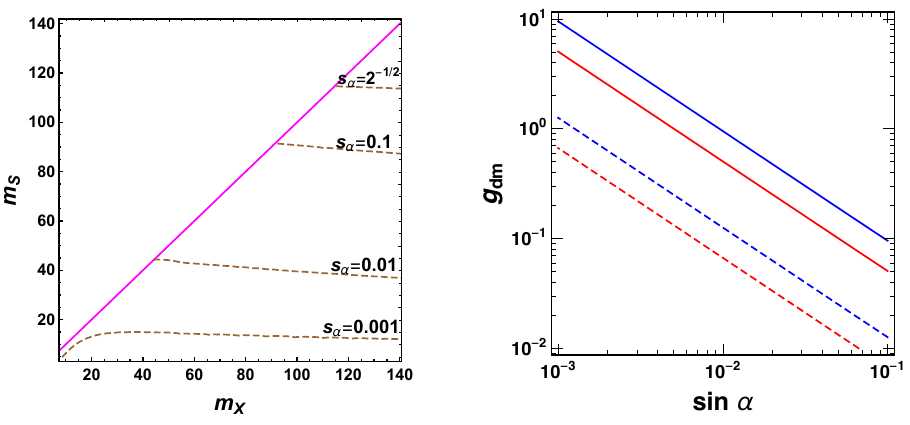
Figure 2 . Left panel: the direct search limit on the ( m X ; m S ) parameter space with the requirement m X > m S which is the region on the right hand side of the magenta solid line. For a given value p of s (cid:11) ( (cid:17) sin (cid:11) ) (cid:20) 1 = 2, the region above the corresponding dashed (brown) curve is allowed by XENON1T [12]. Here we use g dm = 0 : 173. Right panel: upper bounds of sin (cid:11) and g dm from XENON1T and LZ projected sensitivity [15] denoted by the solid and dashed lines, respectively, where the red line is for m X = 80 GeV, m S = 0 : 8 m X , and the blue for m X = 80 GeV, m S = 0 : 99 m X